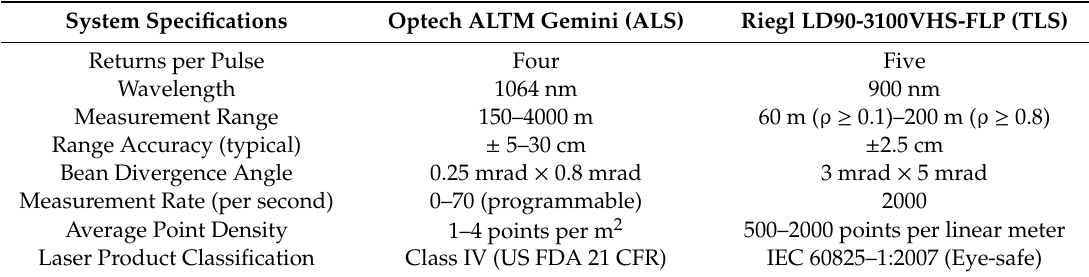
Table 3. LiDAR system specifications for aerial laser scanning (ALS) and terrestrial laser scanning (TLS)